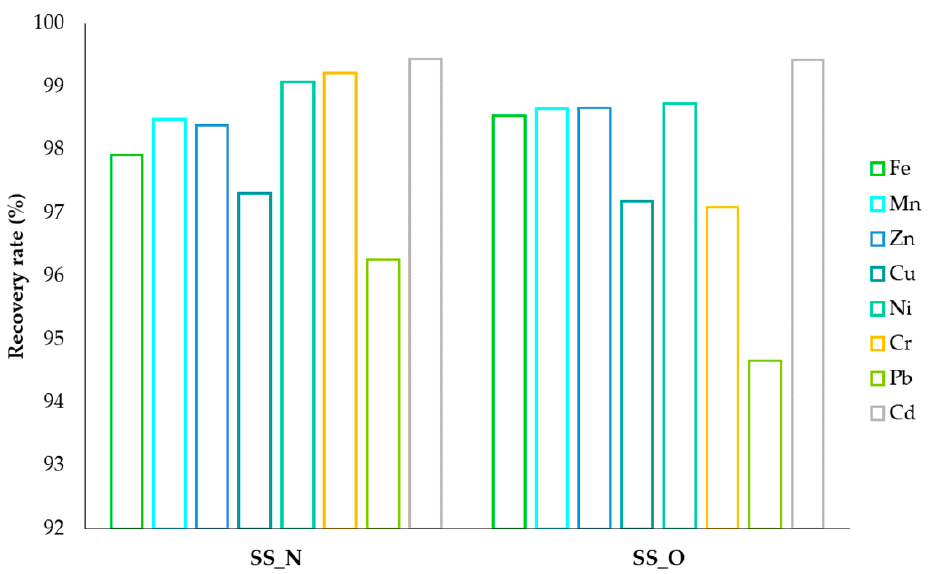
Figure 2. Recovery rate of trace elements from sewage sludge samples (%).